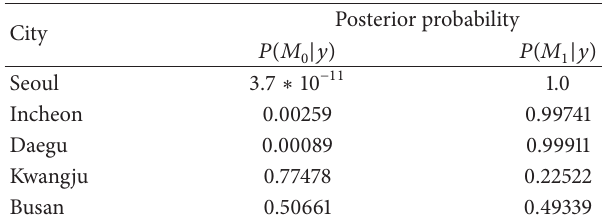
Table 2: The posterior probabilities for each